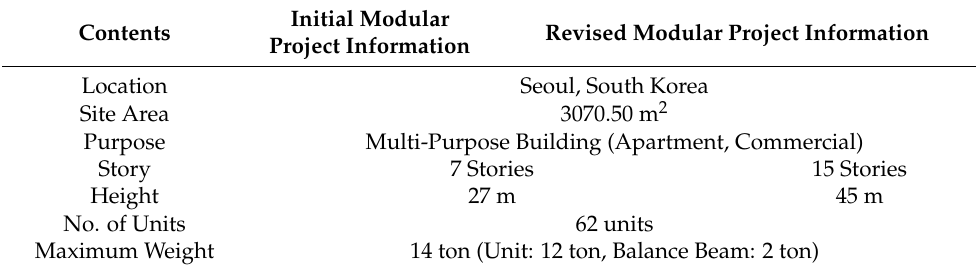
Table 1. Revised case study project